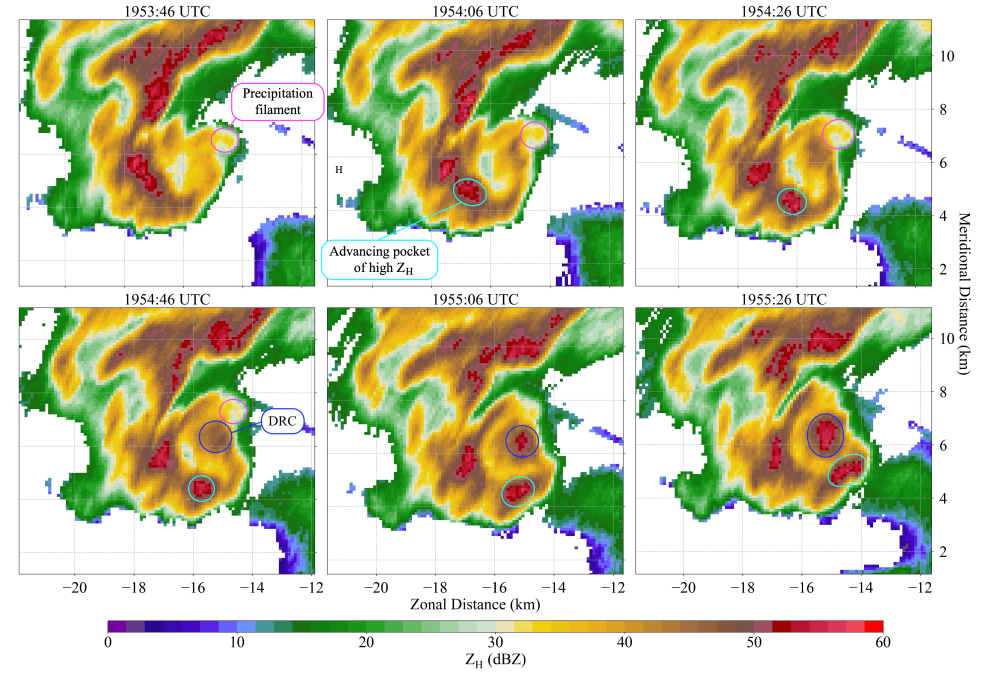
Figure 9. As in Figure 8, except from 1953:46 to 1955:26 UTC, highlighting the advancing Z H gradient during surge